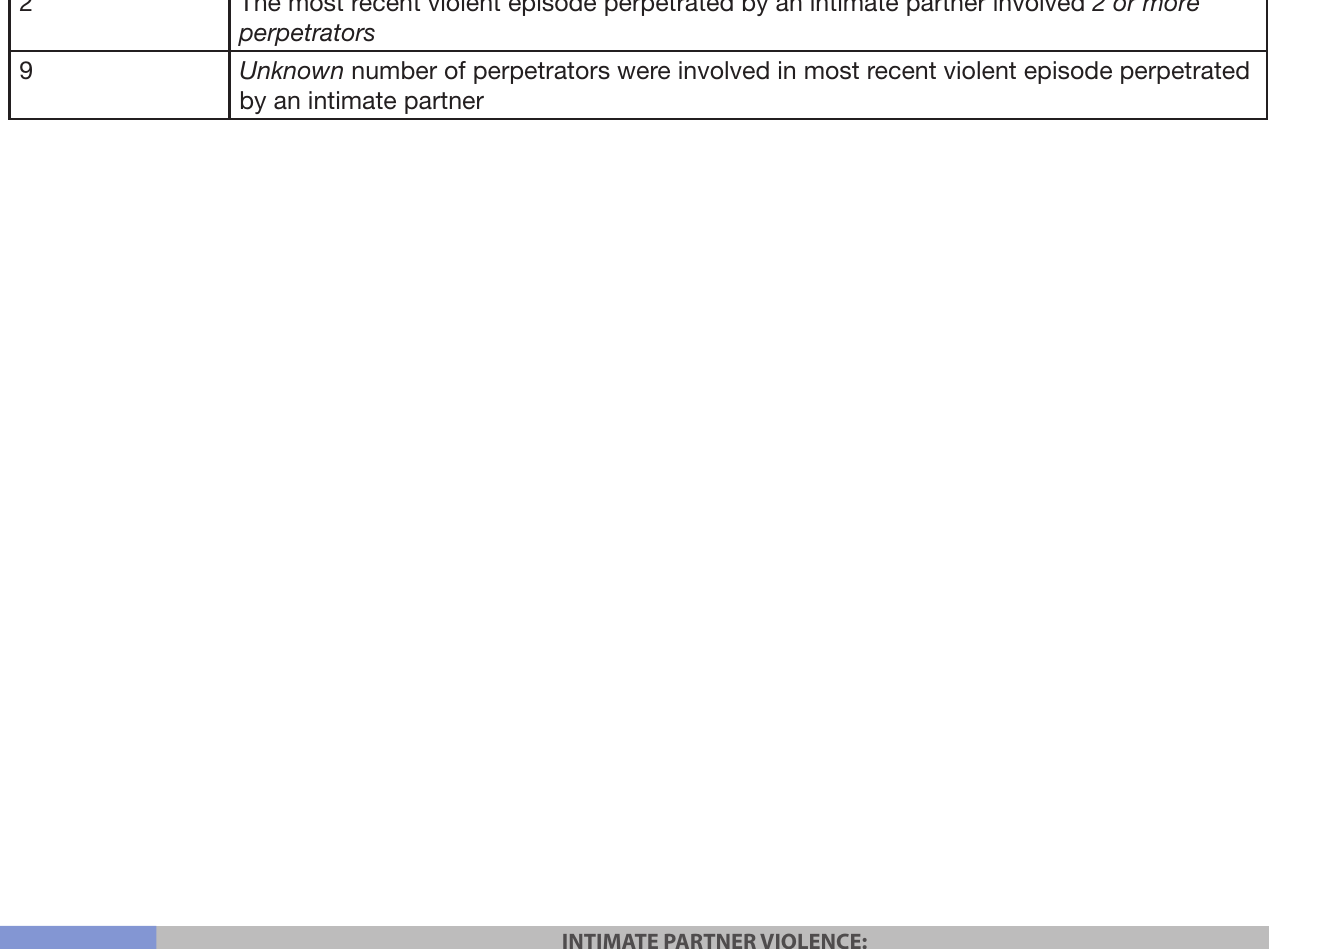
INTIMATE PARTNER VIOLENCE: UNIFORM DEFINITIONS AND RECOMMENDED DATA